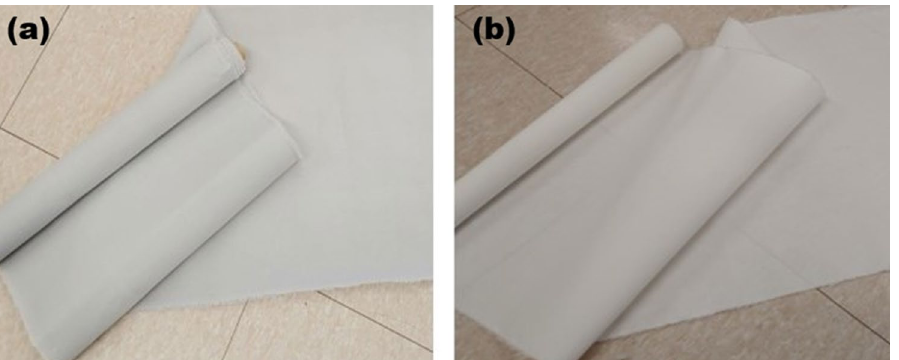
Figure 8. Woven radiation-shielding fibers: ( a ) fabric using tungsten composite yarn and ( b ) fabric using PET fiber containing BaSO 4 .